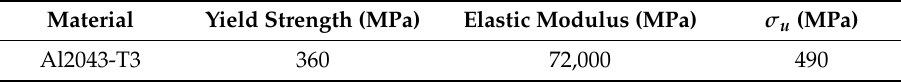
Table 2. Detailed information of the piezoelectric (PZT) (SM412) sensors.